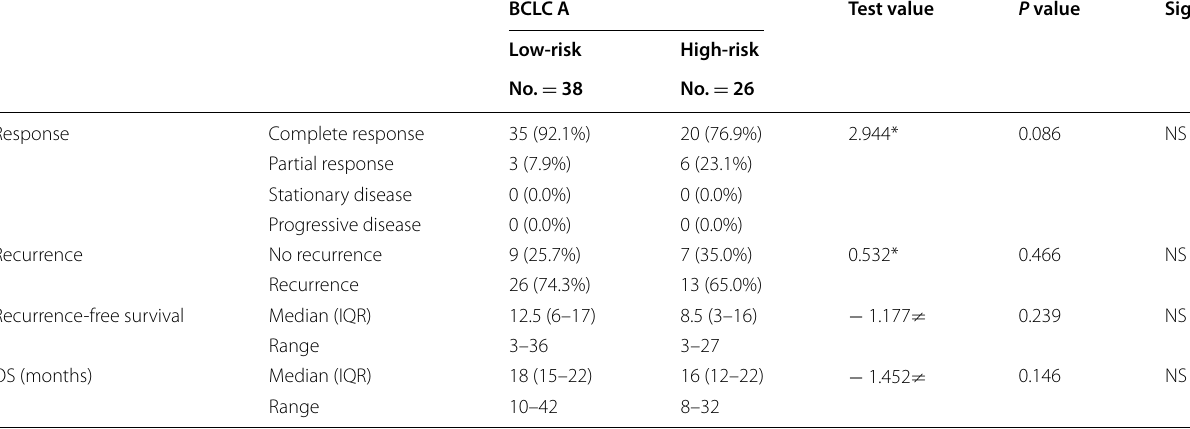
Table 9 Classifying BCLC A cases into low- and high-risk groups for TACE according to the AFP model